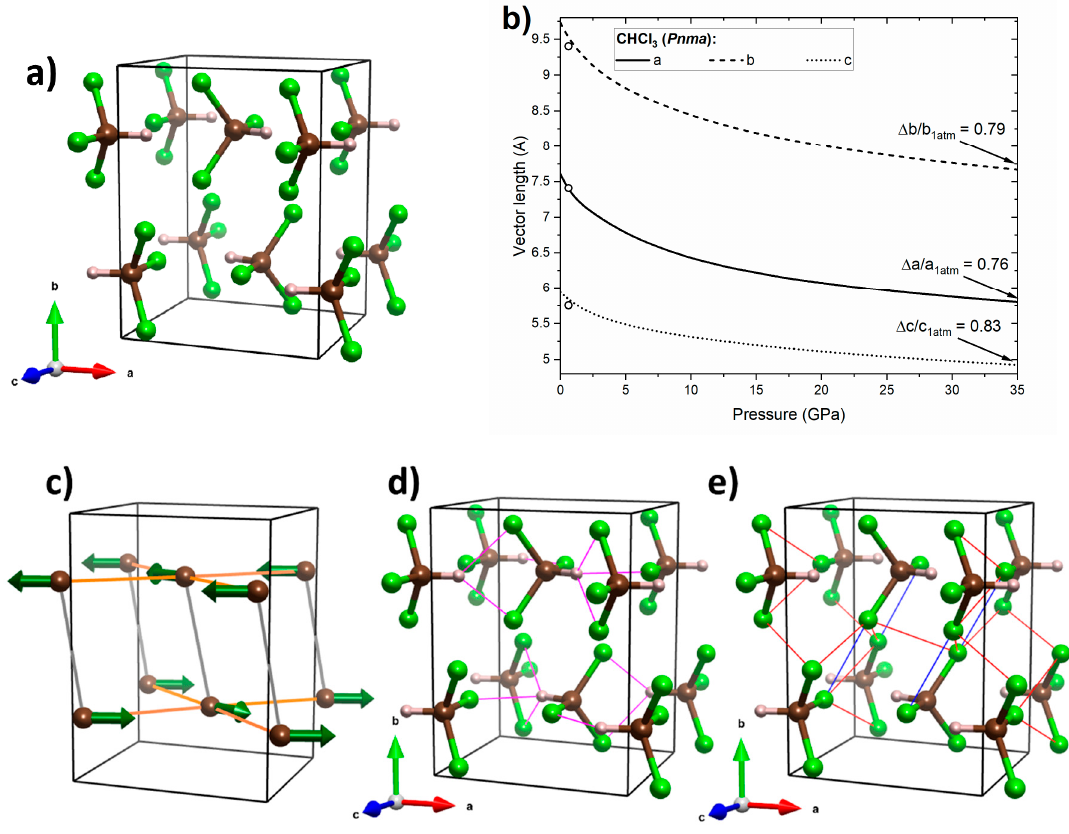
Figure 6. ( a ) Crystal geometry of CHCl 3 in the Pnma structure at 32 GPa, where brown / grey / green balls mark C / H / Cl atoms, respectively; ( b ) calculated pressure dependence of the lattice vectors of the this structure (black lines) together with experimental data from ref. [21] (open circles); ( c ) interactions between molecular dipoles (green arrows), where those energetically favourable are shown in orange and those unfavourable ones are shown in grey; ( d ) the network of hydrogen bonds (magenta lines); and ( e ) Cl ··· Cl interactions, with type II interactions shown in blue and type I interactions in red.